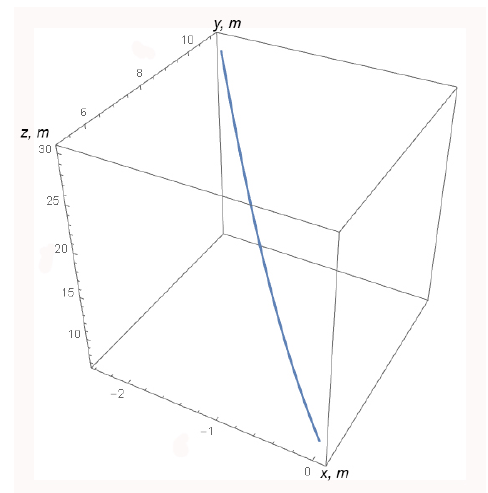
Figure 22. Movement of the center of mass of the beam: х С – blue, y С – green, z С – red